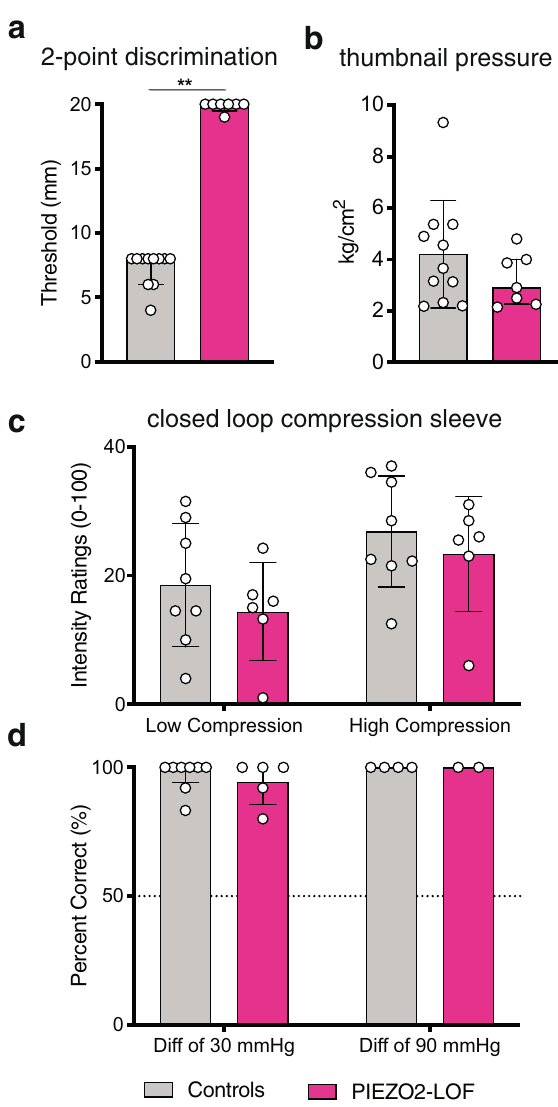
Fig. 3 ΡΙΕΖΟ 2 is not required for pressure sensation. a Two-point discrimination task performed on the thenar eminence of the palm (glabrous skin). Participants with ΡΙΕΖΟ 2 De fi ciency Syndrome ( ΡΙΕΖΟ 2 LOF; N = 7) were unable to perform the test at or below cutoff of 20 mm whereas age- and gender-matched controls ( N = 11) had normal discrimination limits (one-sided permutation test ** p ≤ 0.001). Bars display median ratings and interquartile intervals. b Pressure algometer task as described in Fig. 2h legend. There was no difference between ΡΙΕΖΟ 2 LOF participants ( N = 7) and controls ( N = 13) (one-sided permutation test p = 0.13). Bars display median ratings and interquartile intervals. c Intensity of the compression sleeve oscillating between 10 and 30 mmHg (low) or 15 and 65 mmHg (high) was rated on a VAS scale (no sensation = 0; pain threshold = 50). Both ΡΙΕΖΟ 2 LOF participants ( N = 6) and healthy controls ( N = 8) identi fi ed changes in pressure as obvious but